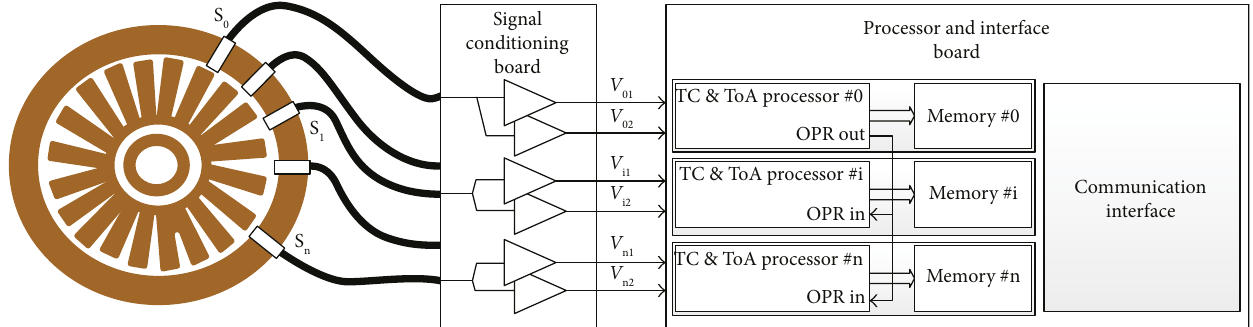
Figure 4: Block diagram showing the measurement synchronization of several sensors.